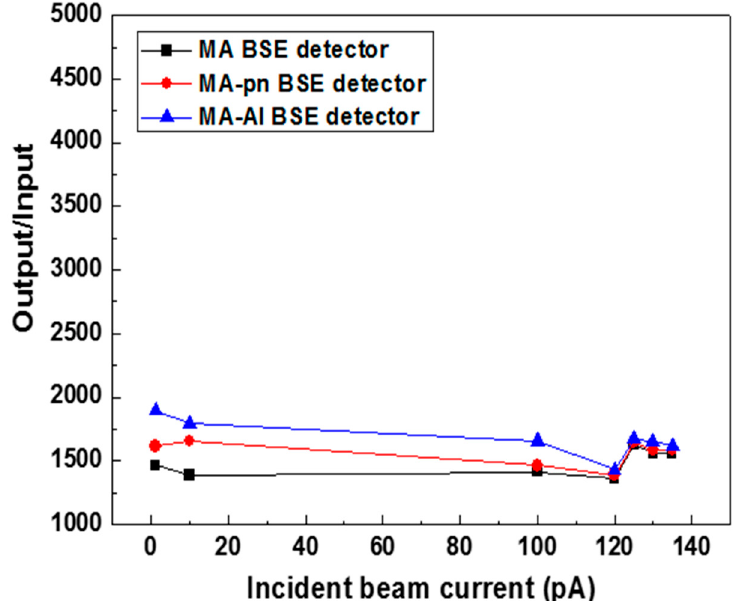
Figure 5. The responsibility gain as a function of different dose rate 15 keV.